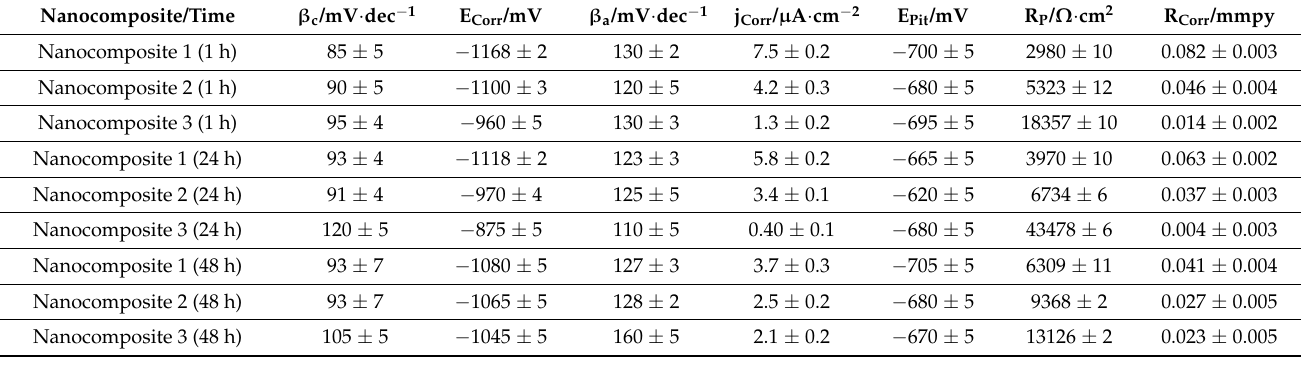
Figure 3. Polarization curves for (1) fist Al-SiC nanocomposite, (2) second Al-SiC nanocomposite and (3) third Al-SiC nanocomposite after 1 h exposure in 3.5% NaCl. Table 2. Polarization data for the different nanocomposites in NaCl solution.